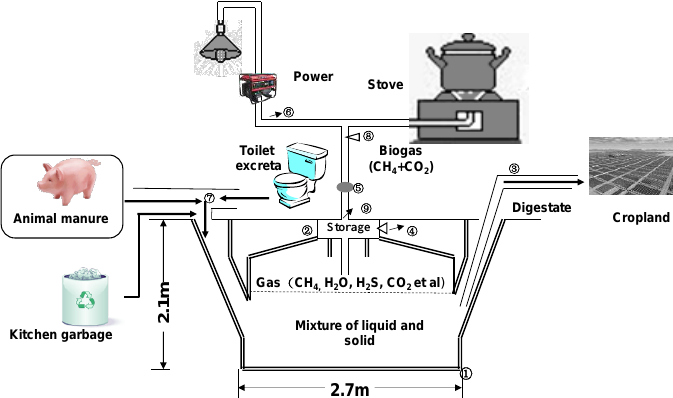
Figure 1. A typical digester is built below ground. Pipe joints, safety valve, purifier and other connectors are common gas leakage points. 1 (cid:13) anaerobic digester, 2 (cid:13) connecter in tank top (CTT), 3 (cid:13) digestate outlet, 4 (cid:13) safety valve, 5 (cid:13) purifier, 6 (cid:13) pipe joint, 7 (cid:13) inlet, 8 (cid:13) valve